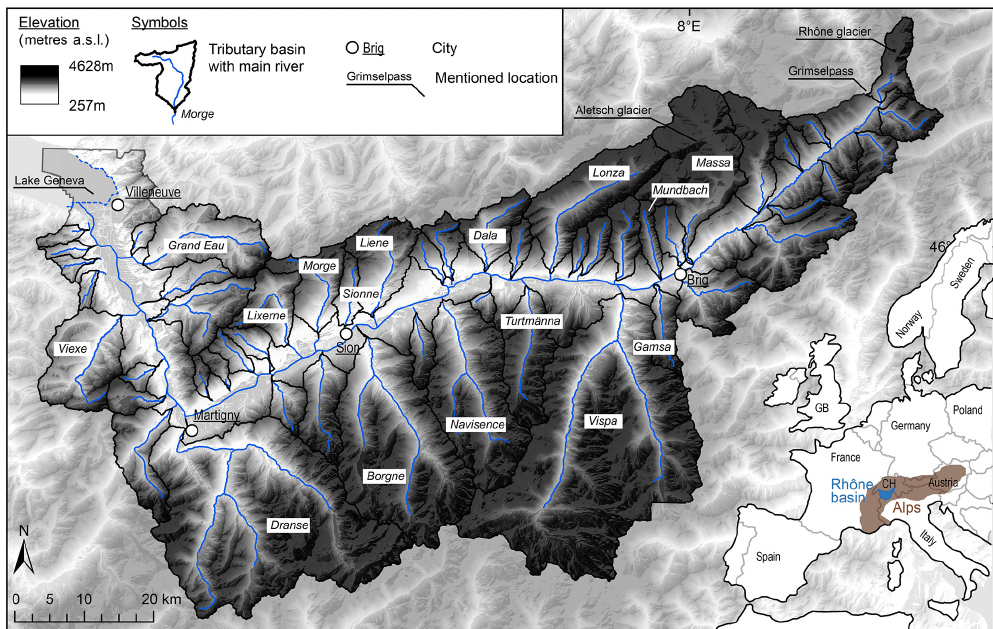
Figure 1. Location map of the study area showing the main Rhône River and 55 main tributary streams (>10km 2 ) that are analysed in this